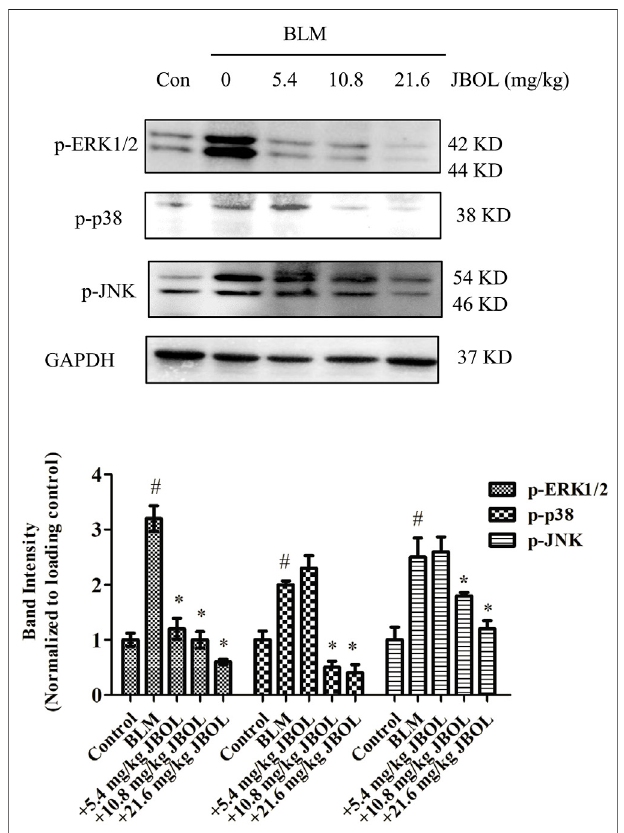
FIGURE 9 | Effect of MAPK phosphorylation in vivo . The expression of p-ERK1/2, p-P38, and p-JNK was determined using the Western blot analysis. n = 3 – 6, # p < 0.05 vs. control; * p < 0.05 vs. the BLM-treated group.